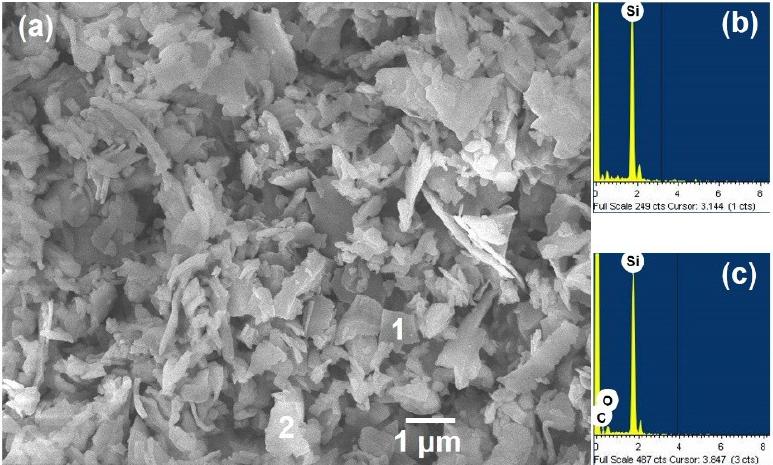
Figure 3. ( a ) SEM image of the Si sludge, ( b ) and ( c ) energy dispersive X-ray spectrometry (EDS) spectra for points 1 and 2, respectively.